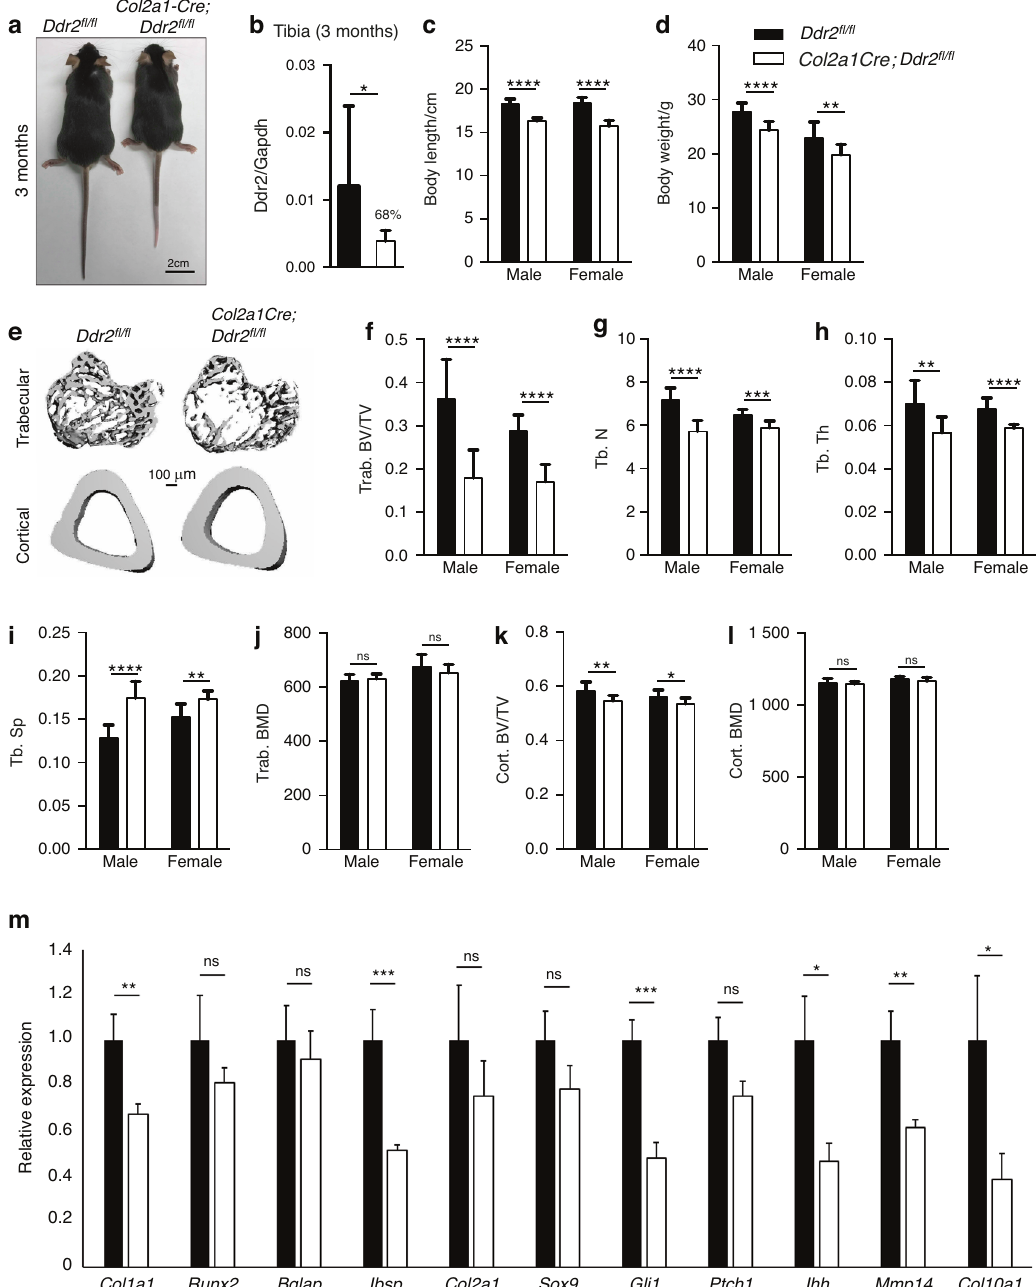
Fig. 5 Requirement for Ddr2 in Col2a1 -positive chondroprogenitor cells. a Gross phenotype of 3 month-old Ddr2 fl / fl and Col2a1-Cre;Ddr2 fl / fl littermates. Col2a1-Cre; Ddr2 fl / fl mice have skeletal dwar fi sm ( n = 20, 10 mice/sex). Scale bar: 2 cm. b Gene expression analysis of Ddr2 from whole 3 month-old tibiae to con fi rm knockout ef fi ciency ( n = 6 mice). c , d Measurements of body length (cm) and weight (g) ( n = 20, 10 mice/ sex). e 3D micro-computed tomography (microCT) models of the tibial metaphysis and cortical mid-shaft in 3 month-old Ddr2 fl / fl and Col2a1- Cre; Ddr2 fl / fl mice. Scale bar: 100 µm. f – j Quantitative data of trabecular bone volume fraction (Trab. BV/TV), trabecular number (Tb.N), trabecular thickness (Tb.Th), trabecular spacing (Tb.Sp) and bone mineral density (Trab. BMD), ( n = 20, 10 mice/sex). k , l Quanti fi cation of cortical bone volume fraction (Cort. BV/TV), and bone mineral density (Cort. BMD), ( n = 20, 10 mice/sex). m Gene expression analysis of osteogenic and chondrogenic differentiation markers. Statistics: Unpaired t-test * P < 0.05, ** P < 0.01; *** P < 0.001; **** P < 0.000 1; ns Not signi fi cant. Data were presented as mean ±